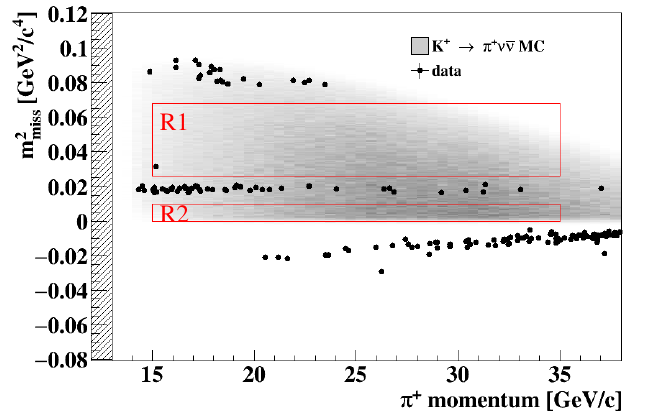
Figure 2. Distribution of the m 2 variable as a function of p π + . The dots are data events passing the miss πν ¯ ν selection, except the cuts on m 2 and p π + . The grey area corresponds to the density of MC events. miss The red lines define the signal regions R1 and R2. One event is observed in